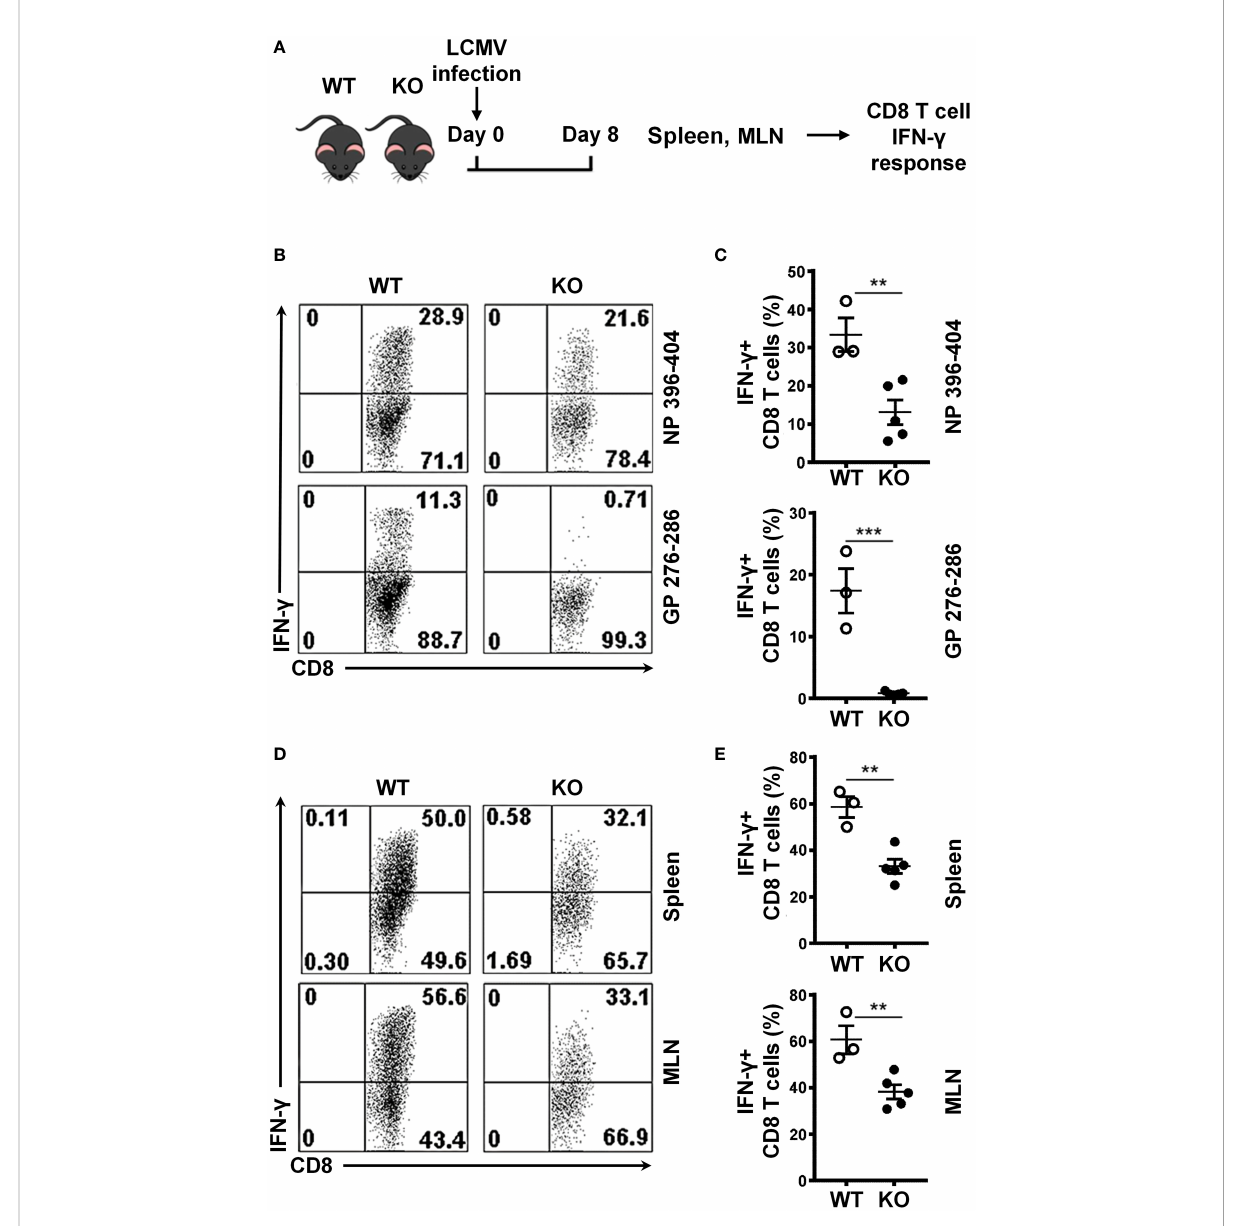
FIGURE 2 SRSF1 is essential for the antigen speci fi c cell mediated immune response to viral infection. (A) Schematic presentation of LCMV infection protocol. Srsf1 -cKO (KO) or WT mice were infected with LCMV Armstrong strain by IP injection. After 8 days of infection, spleen and mesenteric lymph nodes (MLN) were collected for isolation of lymphoid cells (B) Plots show IFN- g + CD8 T cells from spleen cells stimulated with LCMV peptides NP 396-404 or GP 276-286 gated on Thy1.2+ T cells. (C) Graphs show the percentages of IFN- g + CD8 T cells from WT (n=3) and KO (n=5) mice. (D) Plots show IFN- g + CD8 T cells from spleen and MLN cells stimulated with PMA and Ionomycin. (E) Graphs show the percentage of IFN- g + CD8 T cells from WT (n=3) and KO (n=5) mice. Plots show mean ± SEM. p-values **<0.01,